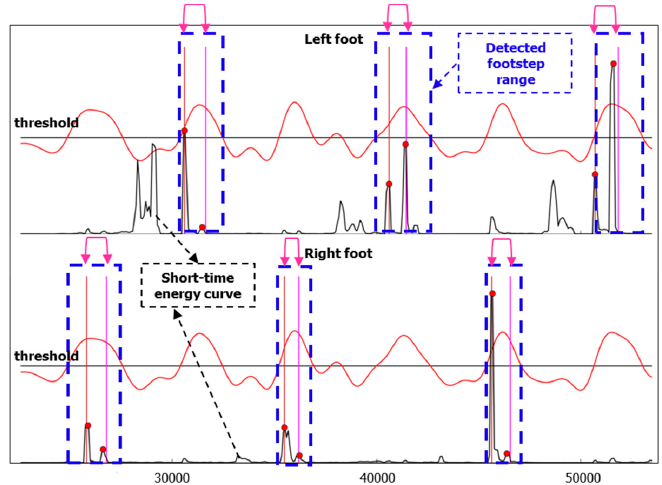
Figure 12. Footstep probability curve after LPF (red); short-time energy curve (black); detected footstep (blue dotted line rectangle); labeled events of heel-strike and toe-on (pink lines); detected heel-strike (left-first red dot); detected toe-on (right-second red dot).